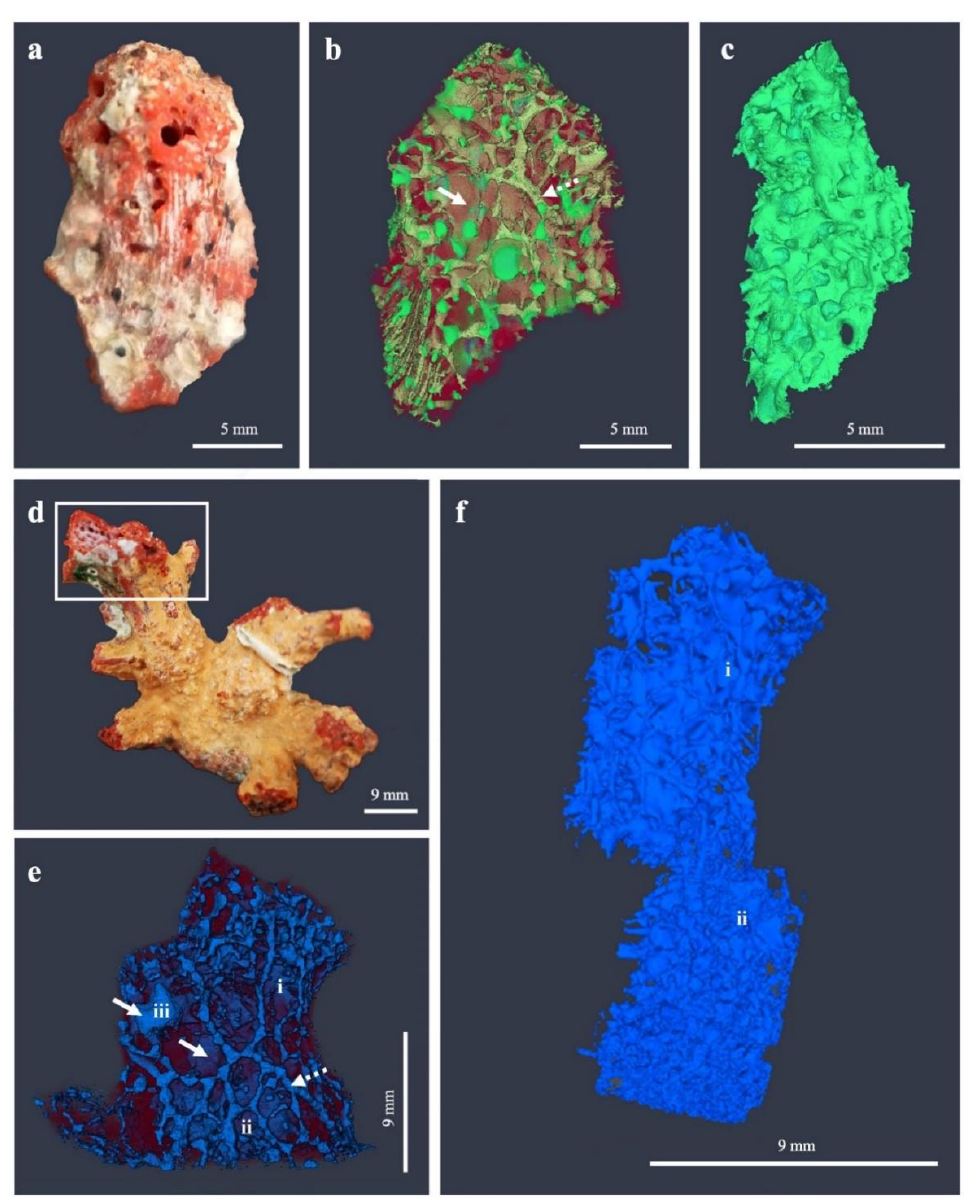
Figure 1. Three-dimensional visualisation of the red coral samples excavated by Alectona millari , from micro-CT reconstructions: ( a ) red coral sample CT3 showing the sponge papillae; ( b ) eroded cavities are in green and coral in transparent red, the continuous arrow points to the chamber of A. millari , surrounded by the chambers of Dotona pulchella mediterranea (dotted arrow); ( c ) system of cavities of A. millari after a manual cleaning of most of D. pulchella mediterranea surrounding erosive activity; ( d ) red coral sample CTX; the area inside the rectangle is the location where the scanning efforts were focused; ( e ) digital cast showing the sponge eroded systems in blue and the coral skeleton in transparent red, the continuous arrows mark two of the chambers of A. millari , while the dotted arrow marks the chambers of D . pulchella mediterranea ; ( f ) erosive activity of A. millari after a manual cleaning of D . pulchella mediterranea erosive cavities. Chambers i and ii correspond to the ones shown in ( e